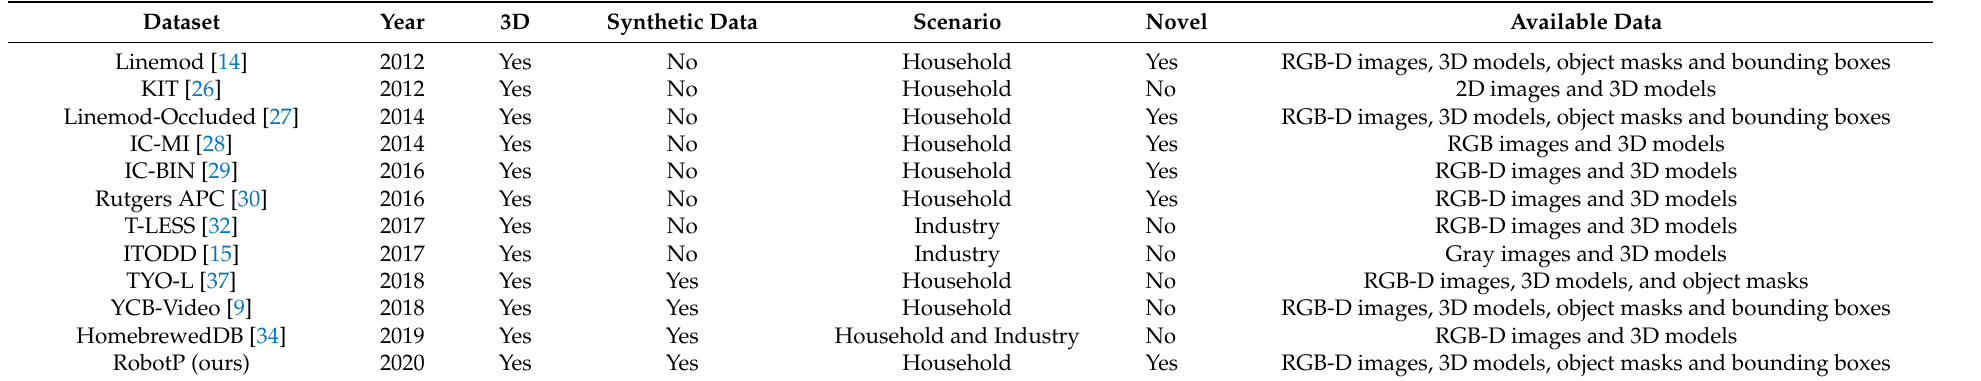
Table 1. Object datasets used for six-dimensional (6D) object pose